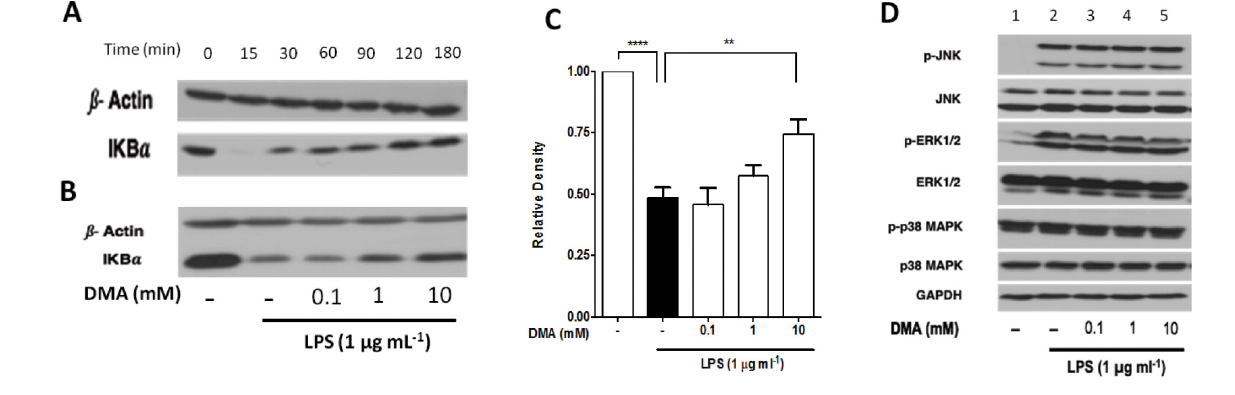
Figure 5. DMA prevents LPS-stimulated I κ B α degradation but does not affect levels of MAPK pathway proteins in RAW 264.7 cells. (A) Time profile analysis of IkB α degradation was determined by immunoblot of IkB α from whole-cell lysate of RAW 264.7 cells at various time points after incubation with LPS (1 μ g mL − 1 ). (B) The effect of various concentrations of DMA on IkB α degradation was determined in the presence or absence of LPS for 15 min. (C) Graphical summary of the relative densities of IkB α expression in panel B quantified using ImageJ software. (D) Immunoblots of downstream proteins of the MAPK pathway after incubation with DMA in the presence of LPS. Representative immunoblots are shown and data are means ± SEM from three independent experi- ments. ** P ≤ 0.01; **** P ≤